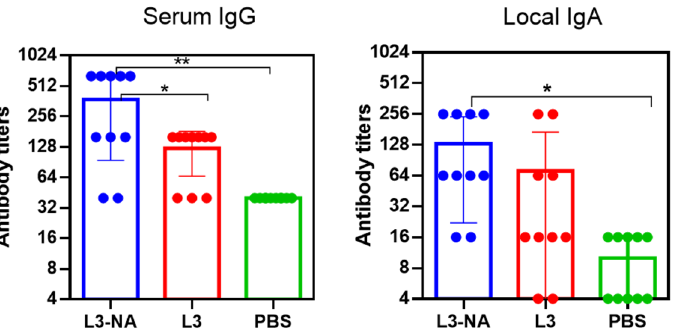
Figure 7. Antibody levels to A/California/07/09(H1N1)pdm09 influenza virus in CBA mice 14 days